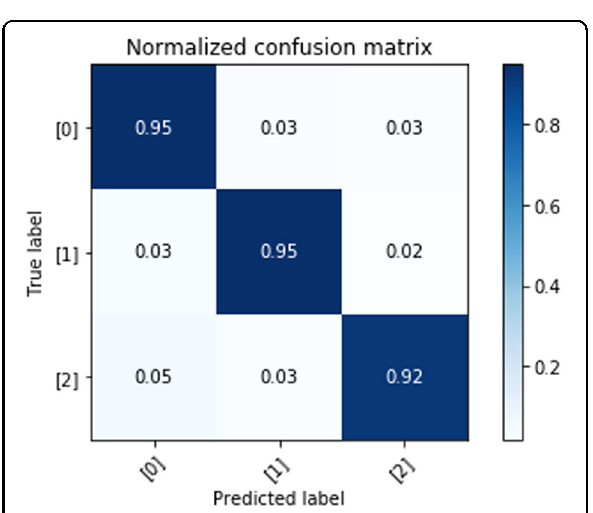
Fig. 4 Normalized confusion matrix for STAI evaluation utilizing visual metrics and CNN-LSTM algorithm. Element value (m, n) of this matrix, and color, represent the probability of predicted STAI level n, given the ground-truth STAI level m, where m and n have labels of 0 (low), 1(intermediate/controllable), and 2 (high). The diagonal elements of this matrix correspond to correct